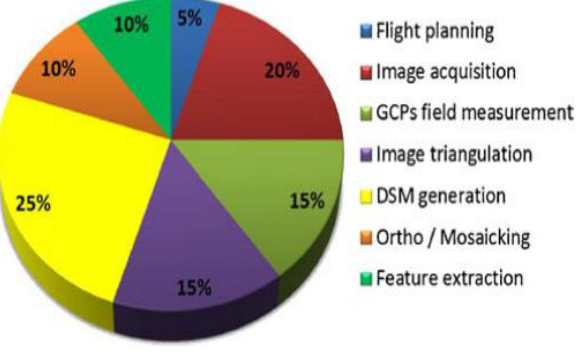
Figure 9. Timing of a typical photogrammetric